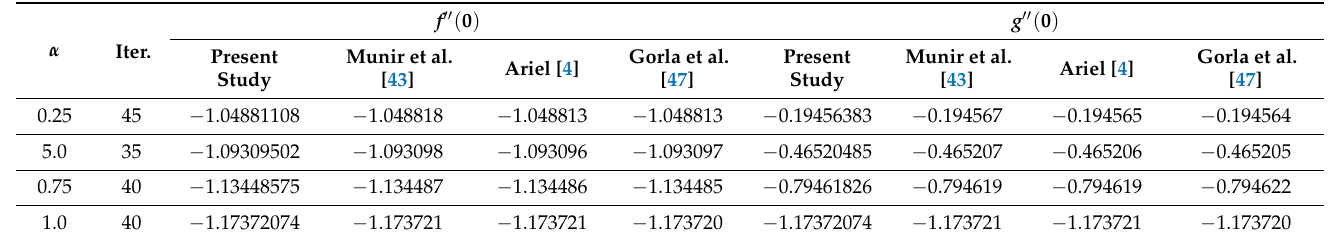
Table 1. Resemblance of skin-friction coefficient f (cid:48)(cid:48) ( 0 ) & g (cid:48)(cid:48) ( 0 ) with the published values of